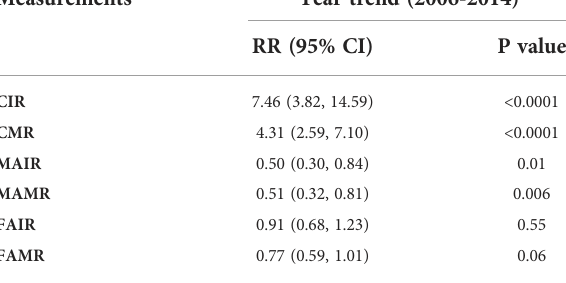
TABLE 1 The integrated year trend of lung cancer risks in seven Chinese cities. Measurements